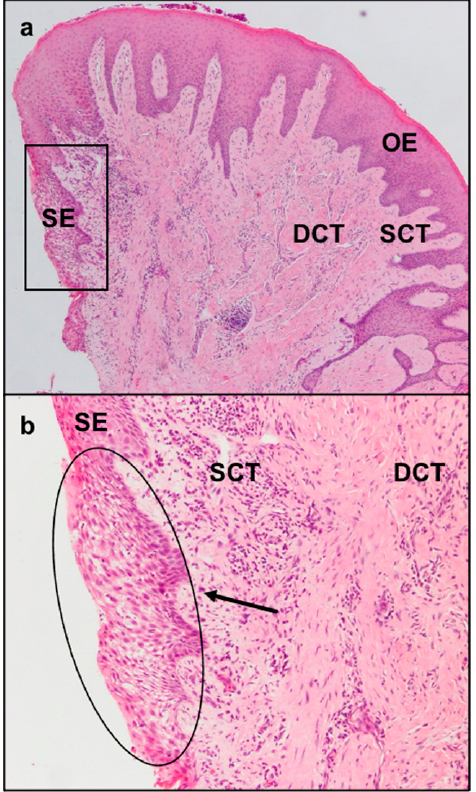
Figure 2. Light microscopy of 4 µm sections of the epithelial and connective tissues of a patient with APE and stained with haematoxylin and eosin. ( a ) Histological section corresponding to the gingival margin at a magnification of 4 × . ( b ) Enlargement of the rectangular area in A at a magnification of 10 × . In the sulcular epithelium (circled area), note the typical signs of inflammation, such as spongiosis and neutrophil exocytosis. OE = oral epithelium; SE = sulcular epithelium; SCT = superficial layer of connective tissue; DCT = deep layer of connective tissue. Ulceration with exposure of the underlying lamina propria and proliferation of capil- laries, distinctive signs of an inflammatory granulation tissue, were evident in the most severe cases (Figure